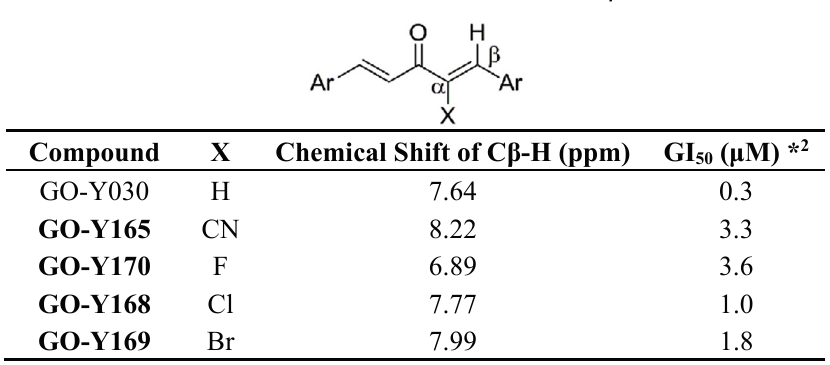
Table 5. Proton chemical shifts of C β